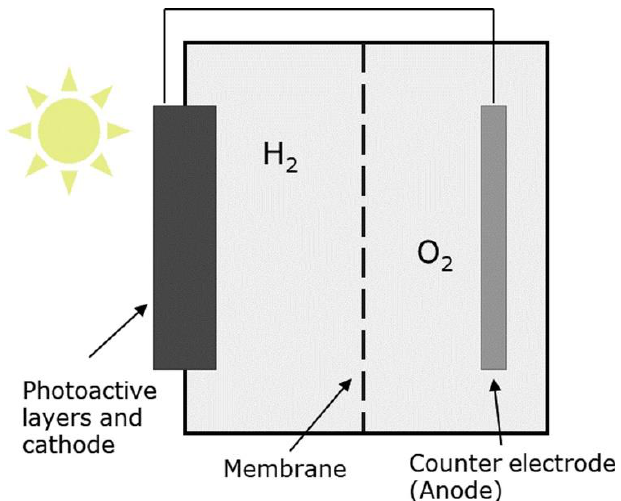
Figure 12. Photoelectrochemical electrolysis. Reproduced with permission from [142].